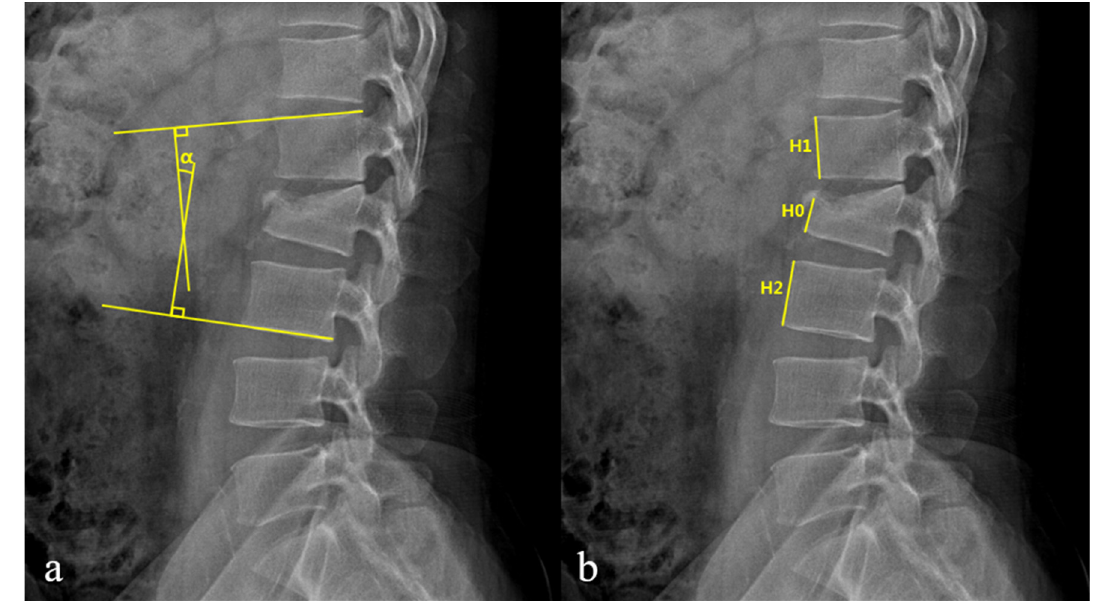
Figure 1. ( a ) The Kyphotic angle (KA, α ) is measured by using cobb angle between the superior endplate of the upper intact vertebra and the inferior endplate of the lower intact vertebra. ( b ) The percentage of loss of vertebral body height (LOVBH) is measured by comparing the fractured anterior body height with the mean of values obtained from the upper and lower intact vertebra.; LOVBH = [(H1 + H2) − 2H0]/(H1 + H2) × 100%.